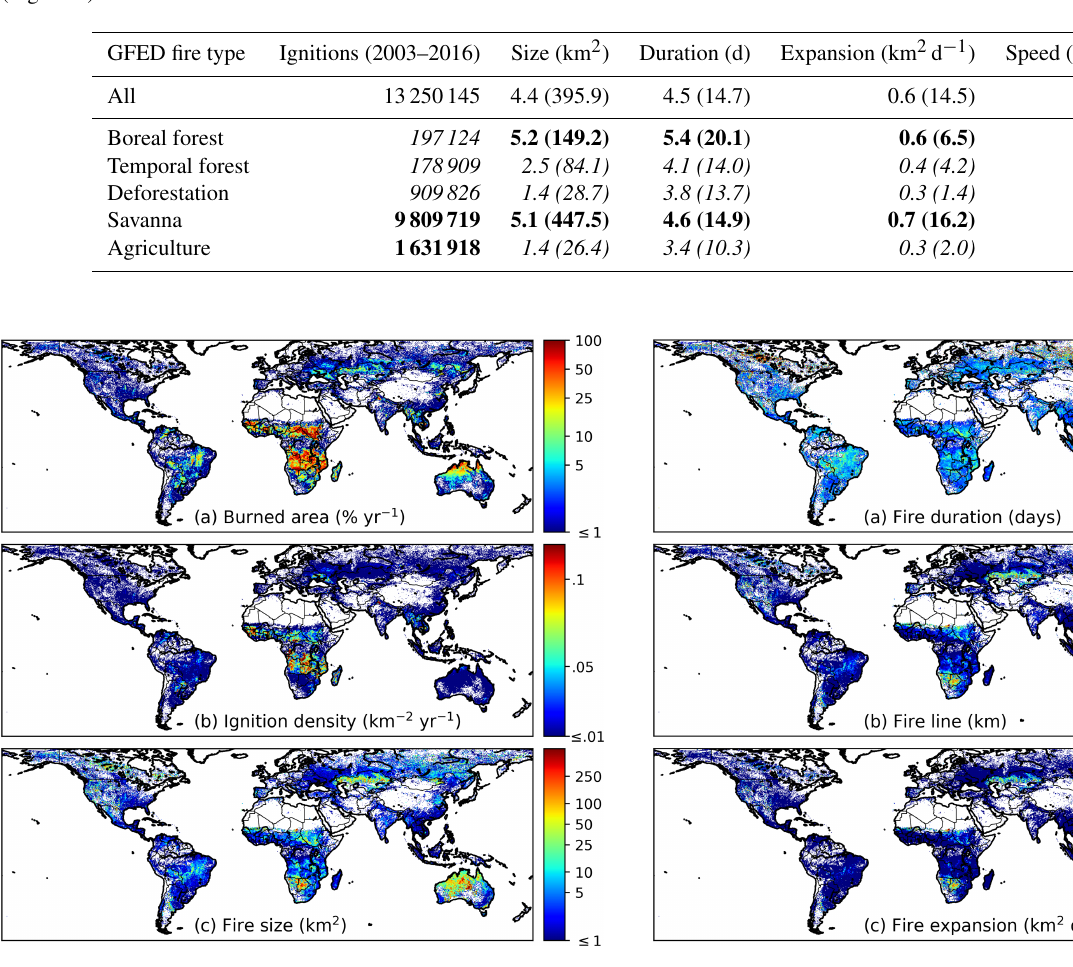
Figure 8. Average global burned area (MCD64A1), ignition den- sity and fire size over the study period 2003–2016. For any given location, burned area in panel (a) can be represented as the product of ignitions per year shown in (b) and fire size shown in (c) .